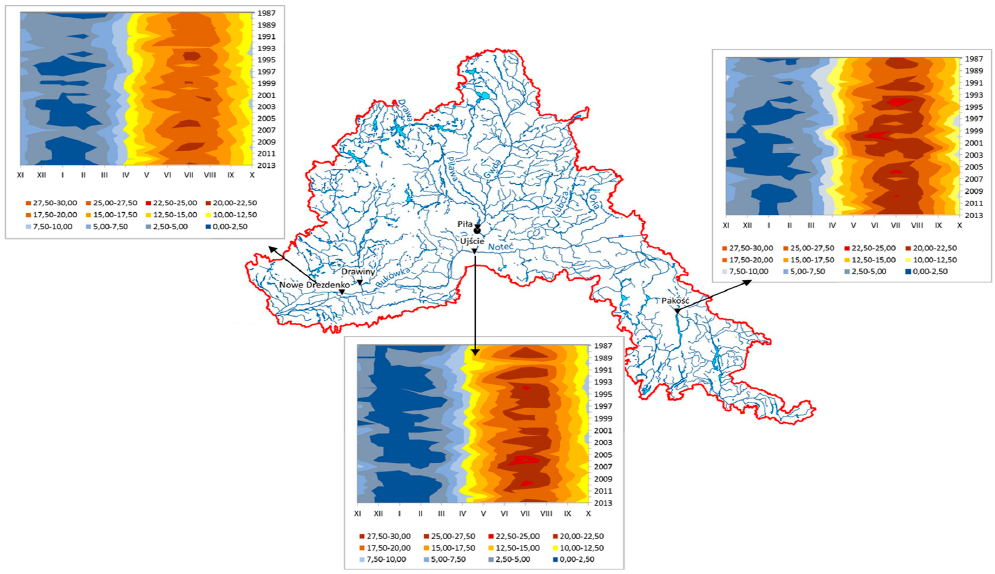
Figure 4. Distribution of the measurement series of Note ć water temperature (Pako ść , Uj ś cie, Nowe Drezdenko) on daily time levels (°C).